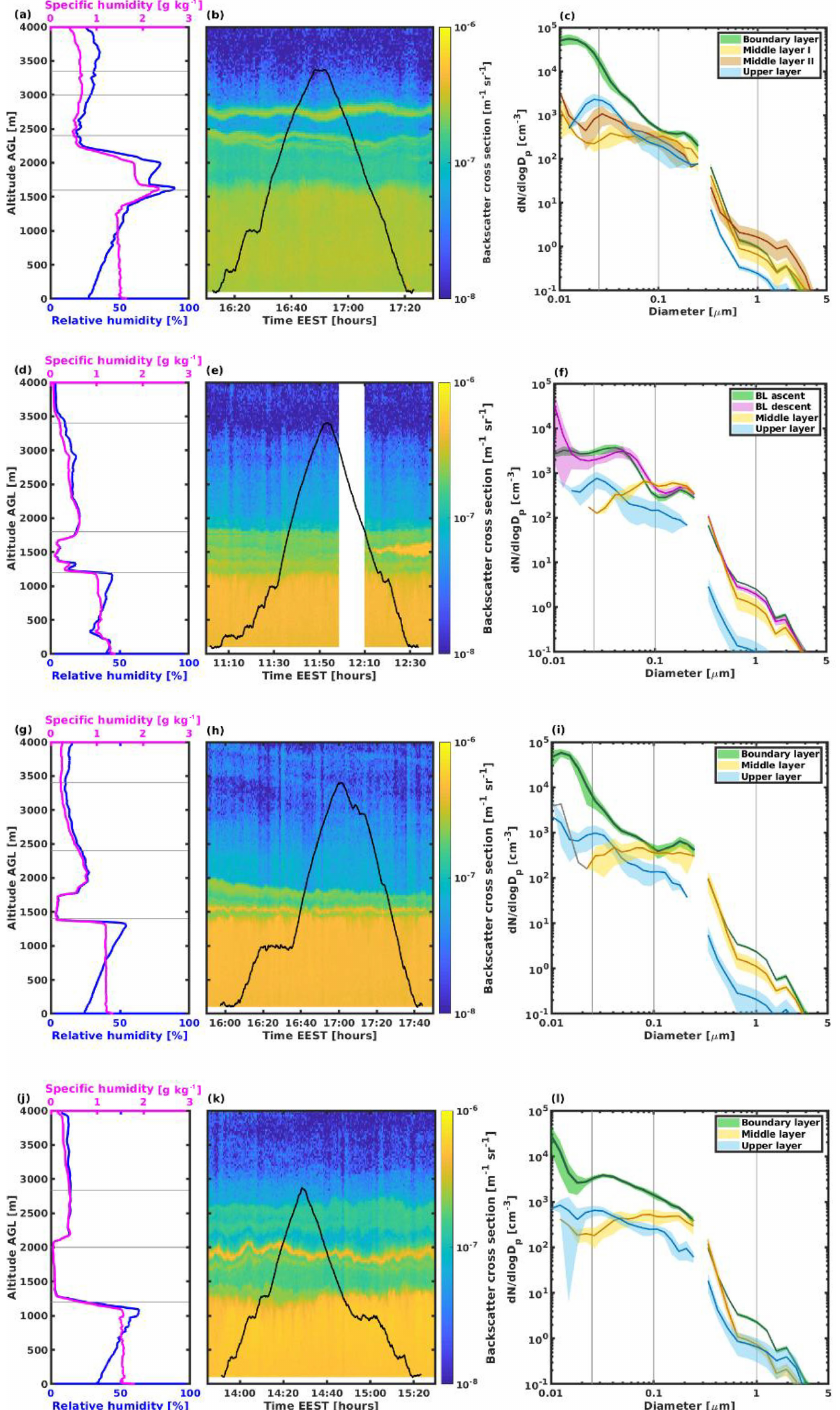
Figure 2. Four panels for each flight during Case I: (a–c) 8 April, (d–f) morning flight on 9 April, (g–i) afternoon flight on 9 April, (j– l) 10 April. Left panels show relative and specific humidity profiles measured by the radiosonde launched closest in time to the flight. Centre panels display HSRL backscatter coefficient, with Cessna flight altitude superimposed in black. Right panels present layer-averaged aerosol size distributions from combined SMPS and OPS measurements for diagnosed layers. Mean and 1 standard deviation are shown for each layer. Grey lines show limits of the aerosol modes: nucleation, Aitken, accumulation, and